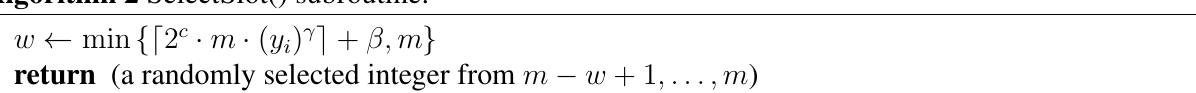
Algorithm 2 SelectSlot()